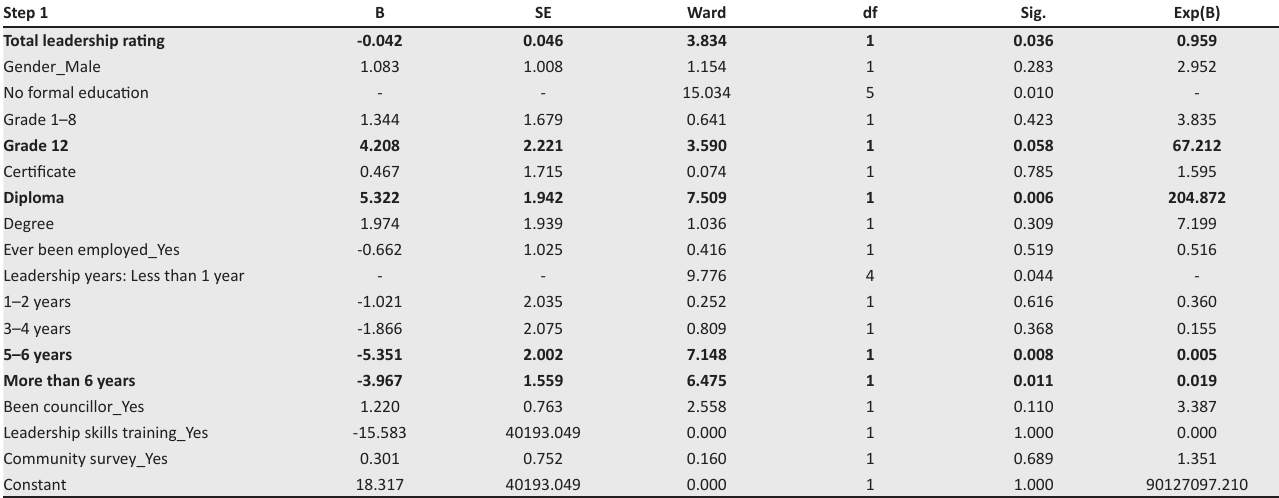
FIGURE 1: Classification of leadership characteristics. TABLE 2: Variables in the regression